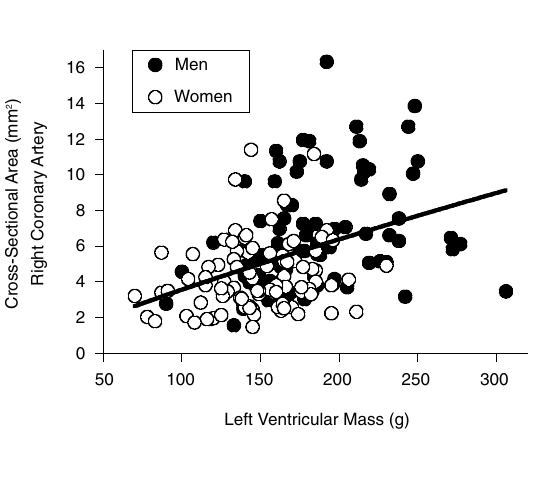
Left main coronary artery cross sectional area per 100 g of left ventricular myocardium Right coronary artery cross sectional area per 100 g of left ventricular myocardium